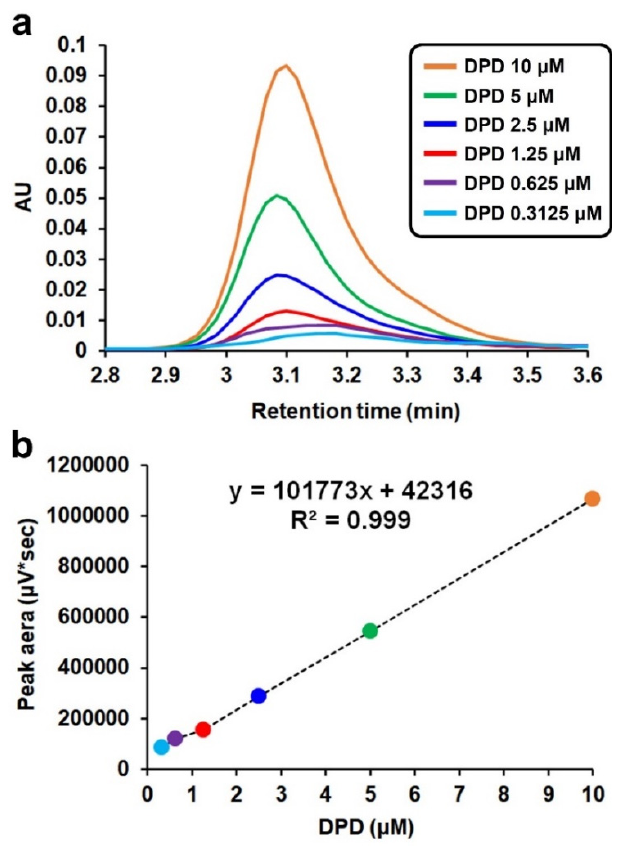
Figure 3. ( a ) Chromatograms of the AI-2 derivative (1-(3-methyl-benzo[g]quinoxaline-2-yl)-ethane- 1,2-diol), a reaction product of DPD and DAN, as a function of DPD concentration (HPLC with a UV detector at 268 nm). ( b ) Plot of peak area versus DPD concentration.